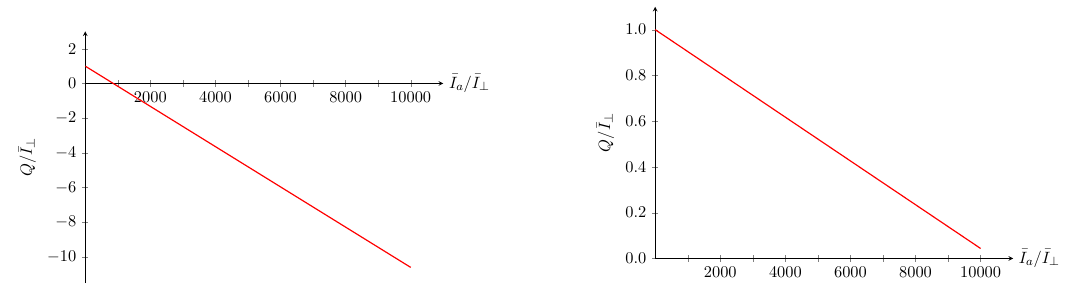
Figure 4 . (Normalized) Stokes parameter Q= (cid:22) I ? at in(cid:12)nity for the benchmark point m a = 10 (cid:0) 8 keV, g = 5 10 (cid:0) 17 keV (cid:0) 1 , r 0 = 10 km, B 0 = 20 10 14 G and (cid:18) = (cid:25)= 2 in function of (cid:22) I a = (cid:22) I ? at the (cid:2) (cid:2) surface assuming (cid:22) I k = (cid:22) I ? 0 at the surface. The left panel corresponds to ALP energy ! = 1 (cid:24)